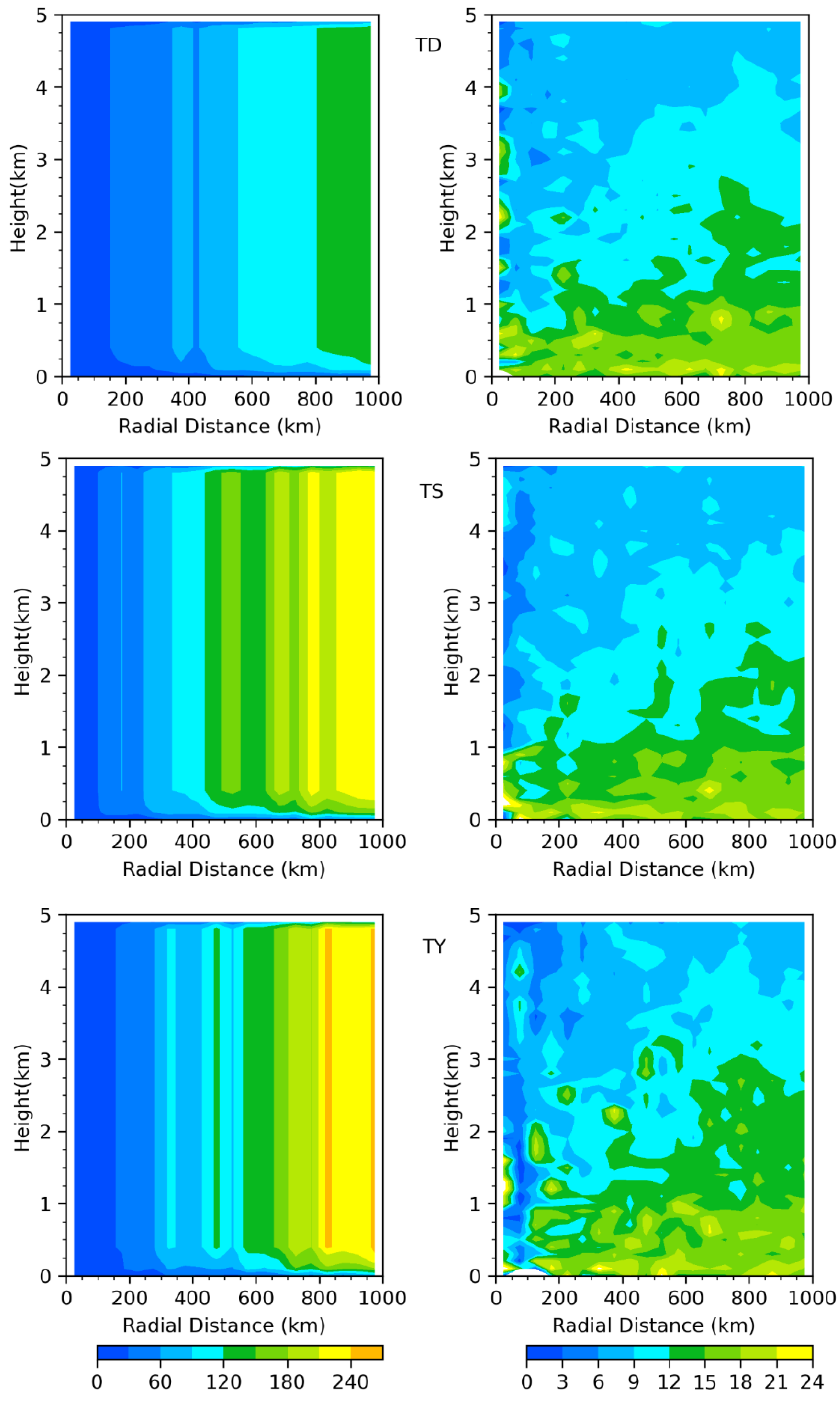
Figure 8. COSMIC-2 RO profile counts ( left ) and the standard deviations (N-unit km − 1 ) of the N i vertical gradients ( right ) calculated in each 50-km radial distance and 0.1-km height box over the western Pacific: ( top ) TD, ( middle ) TS, and ( bottom ) TY.